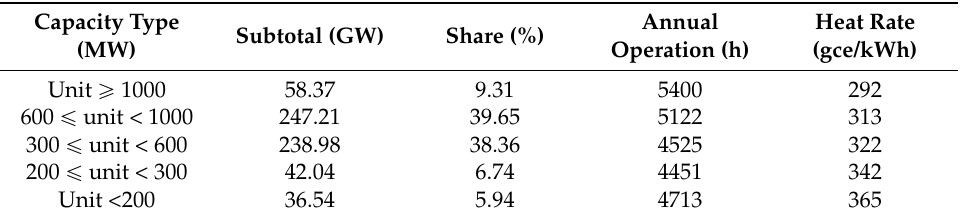
Table 6. Statistics on coal power plants in China’s main generators, 2012.